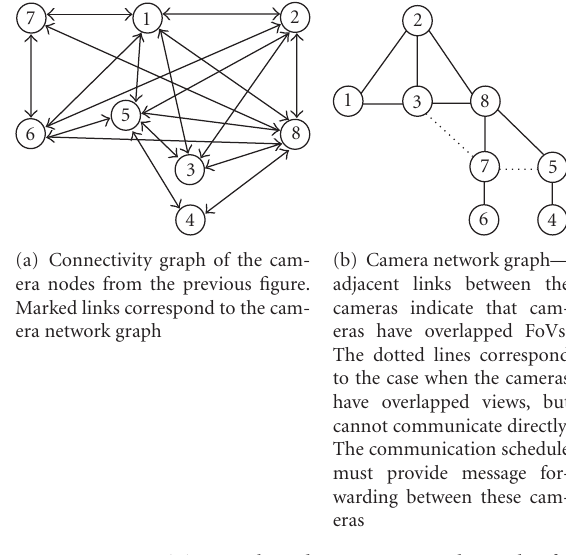
Figure 6: Connectivity graph and camera network graph of the FireFly system